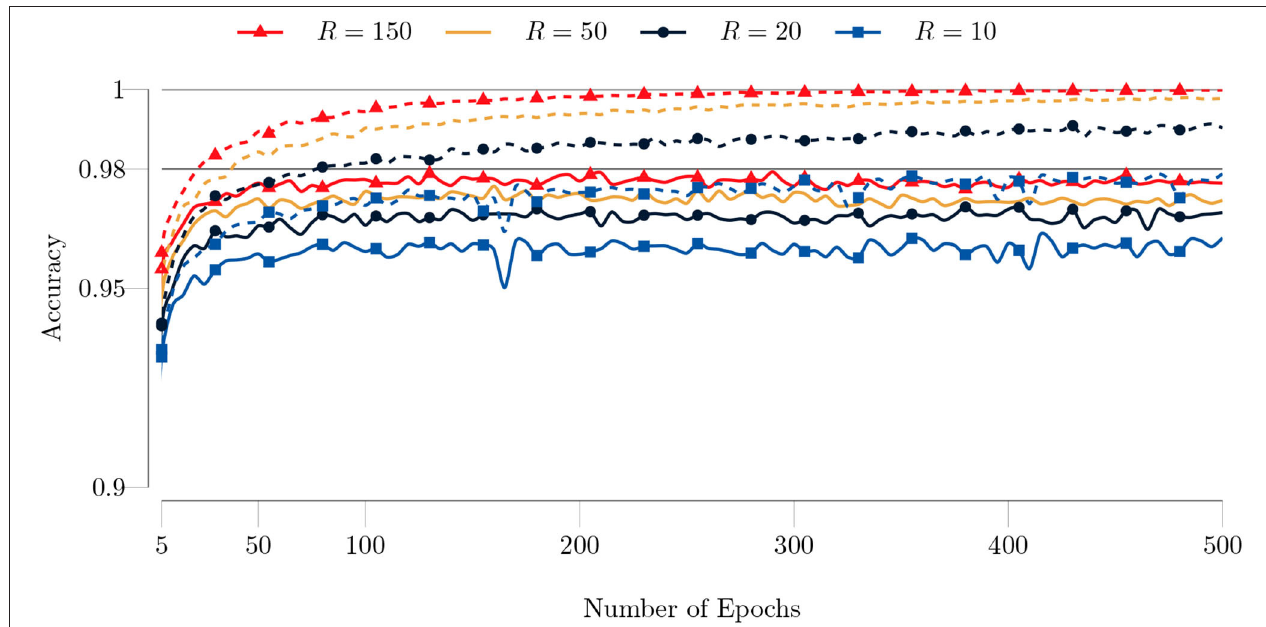
FIGURE 13 | Test (solid lines) and training (dashed lines) accuracies of the type II model for the MNIST dataset with respect to the number of epochs. The full training set (60,000 images) and test set (10,000 images) are used. The batch size is set to 200 and the maximum number of GN iterations is set to 1. Both the test and training accuracy increase as the rank increases. The improvement in the accuracy gets smaller as the rank increases. The algorithm achieves around 100 % training accuracy after 200 epochs.